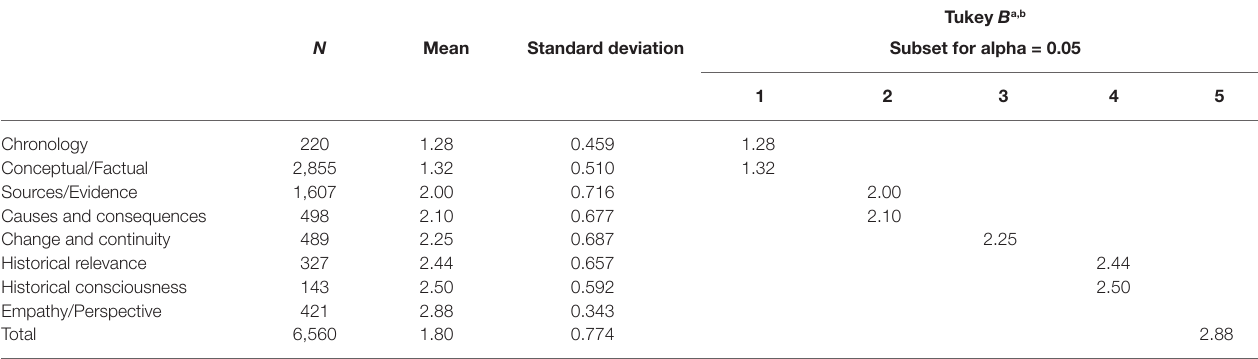
TABLE 8 | Cognitive level according to historical concepts and results of Tukey B test. N Mean Standard deviation